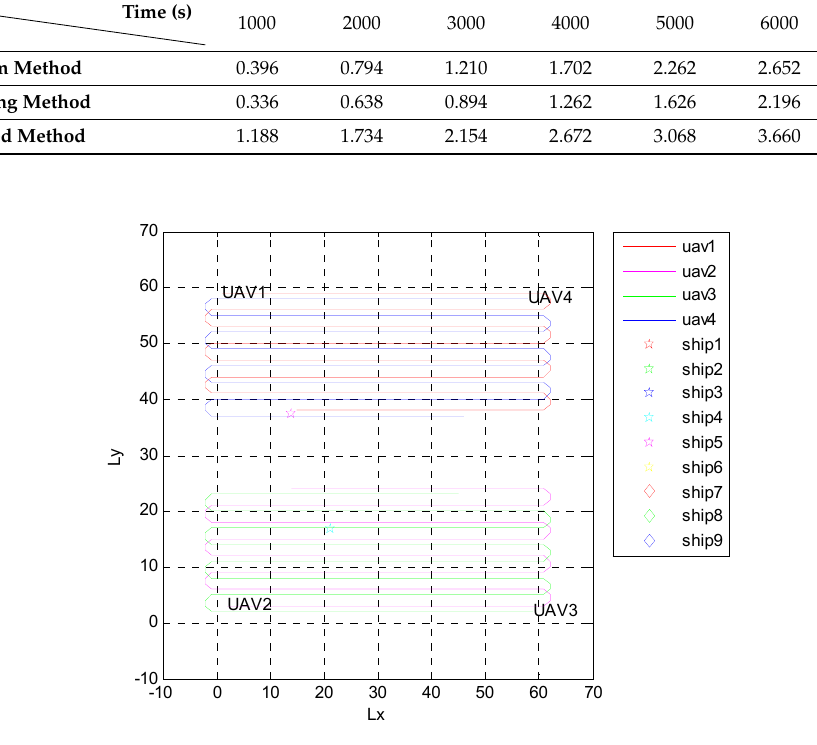
Figure 6. Traversing search result.